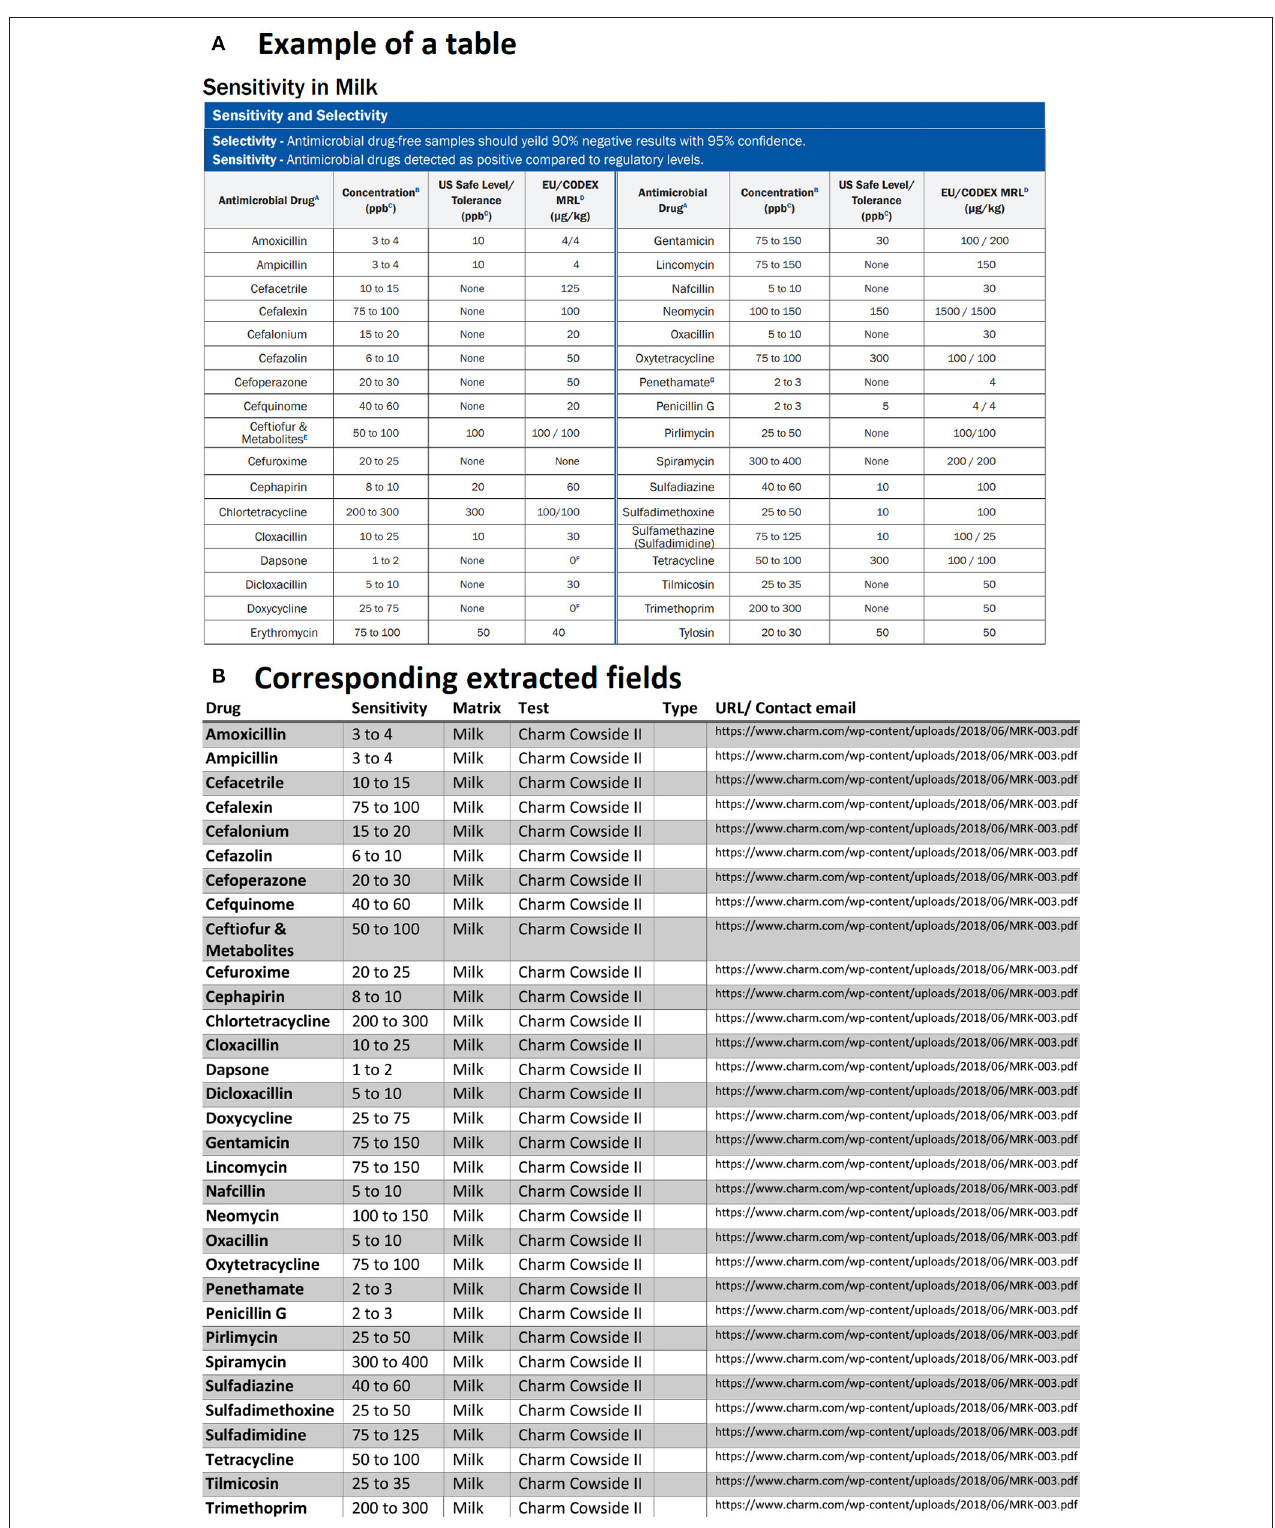
FIGURE 7 | An example of data table extraction for “Charm Cowside II” and the corresponding fields cleaned in a table.